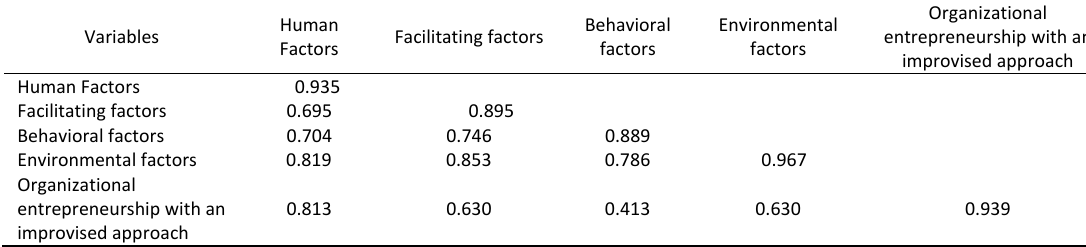
Table 3: Divergent validity in variables